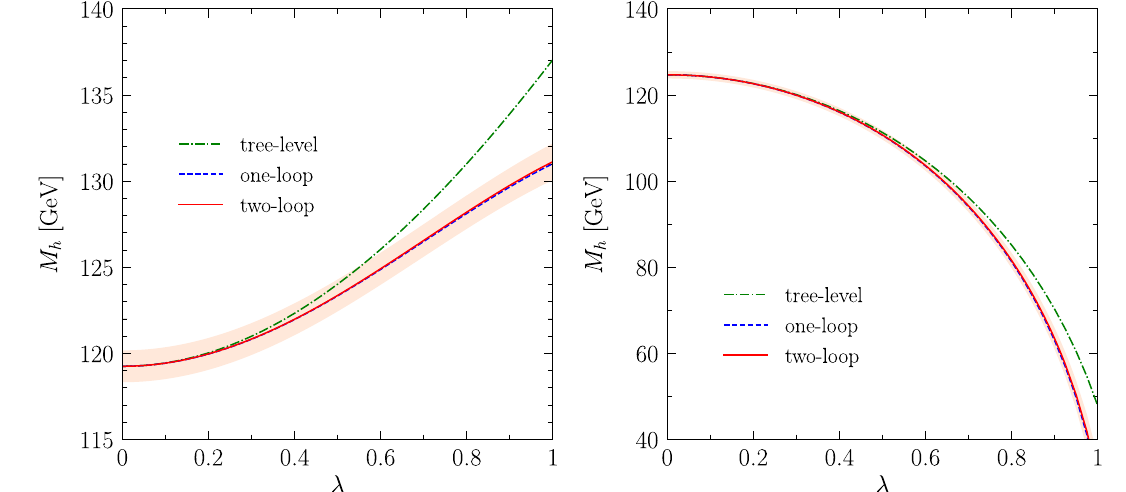
Fig. 1 Higgs-mass prediction as a function of λ , for tan β = 3 (left) or tan β = 5 (right), in the NMSSM scenario described in the text. The three lines in each plot correspond to different accuracies of the